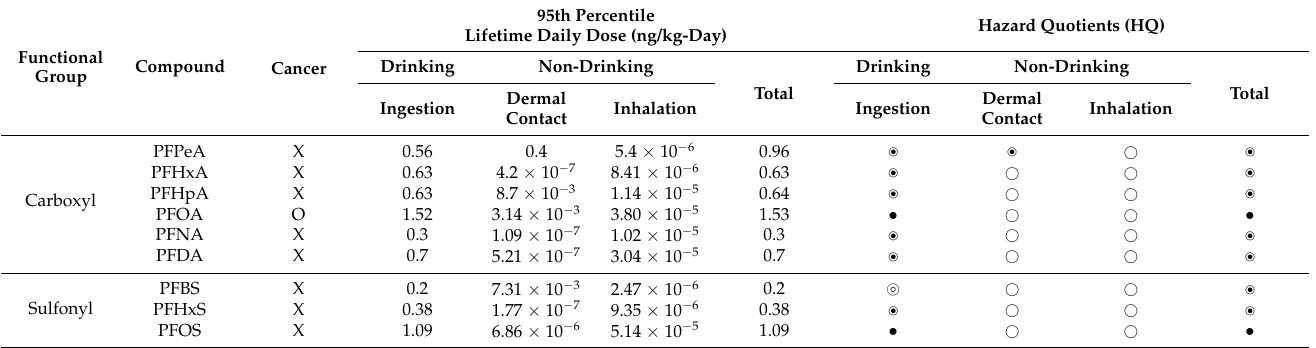
Figure 7. Assessing the PFAS contamination source by using the PFNA/PFOA ratio–PFHpA/PFOA ratio. Table 5. Risk and exposure assessment results of PFASs in groundwater monitored from 2018 to 2020.